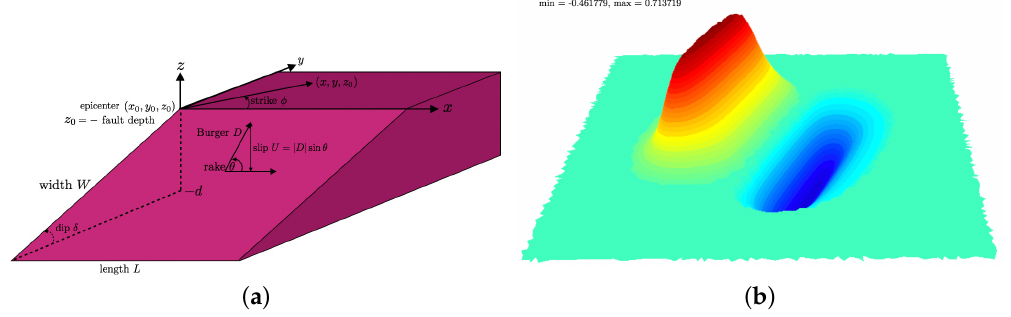
Figure 7. Geometry of the source model ( a ) and the initial solution for η (( b ), min = − 0.46 m, max = 0.71